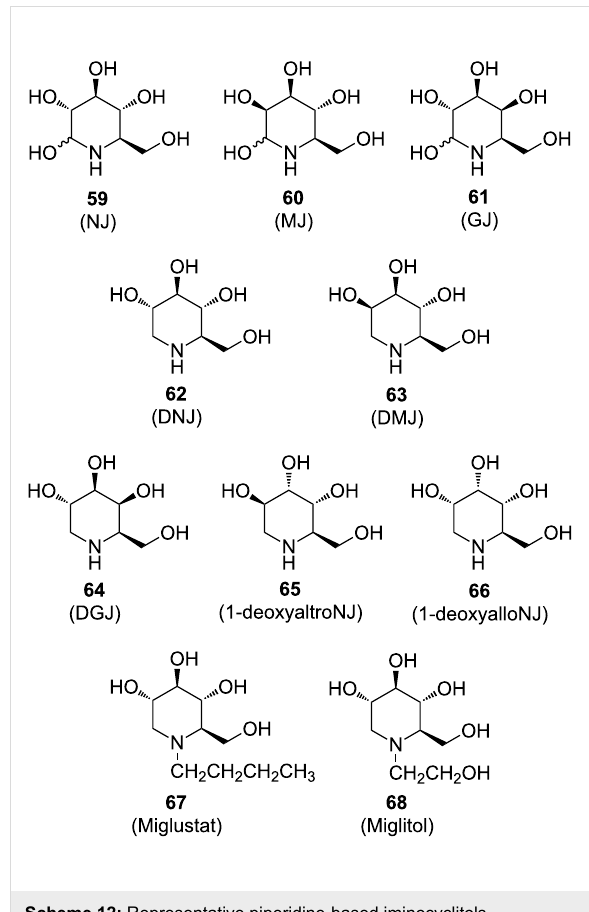
Scheme 12: Representative piperidine-based